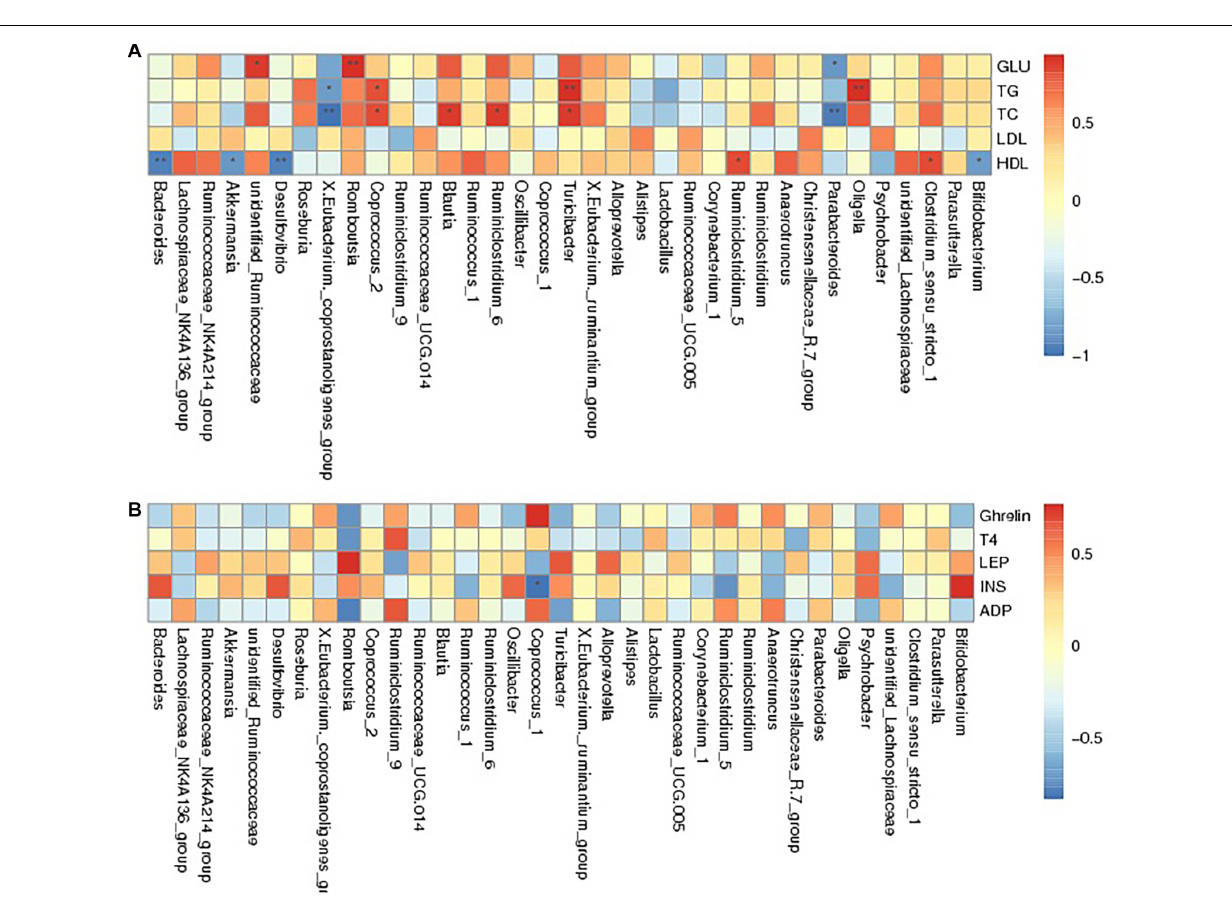
FIGURE 5 | Spearman association analysis between gut microbiota and metabolic parameters at the genus level. The depth of the color corresponded the extent of relevance between gut microbiota and metabolic parameters, red meant positive correlation and blue meant negative correlation. (A) Glucolipid metabolism parameters and (B) Serum hormone. *Correlation was significant at the 0.05 level, **Correlation was significant at the 0.01